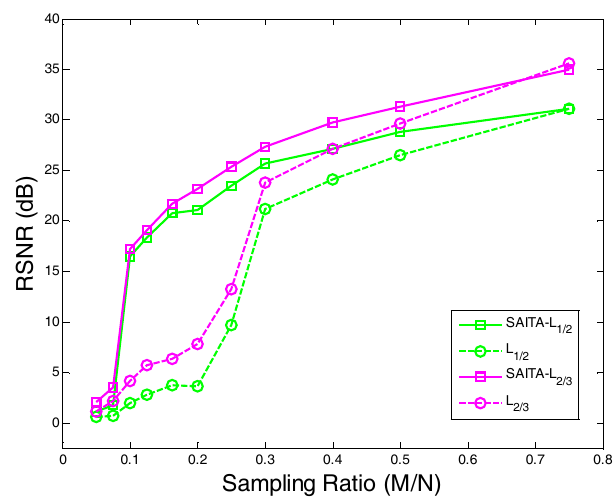
Figure 13. The RSNR of the proposed SAITA- L p , ( p ∈ { 1/2, 2/3 } ) algorithm and the L p , ( p ∈ { 1/2, 2/3 } ) algorithm versus the sampling ratio for the mSNR = 40 dB 2D MRI